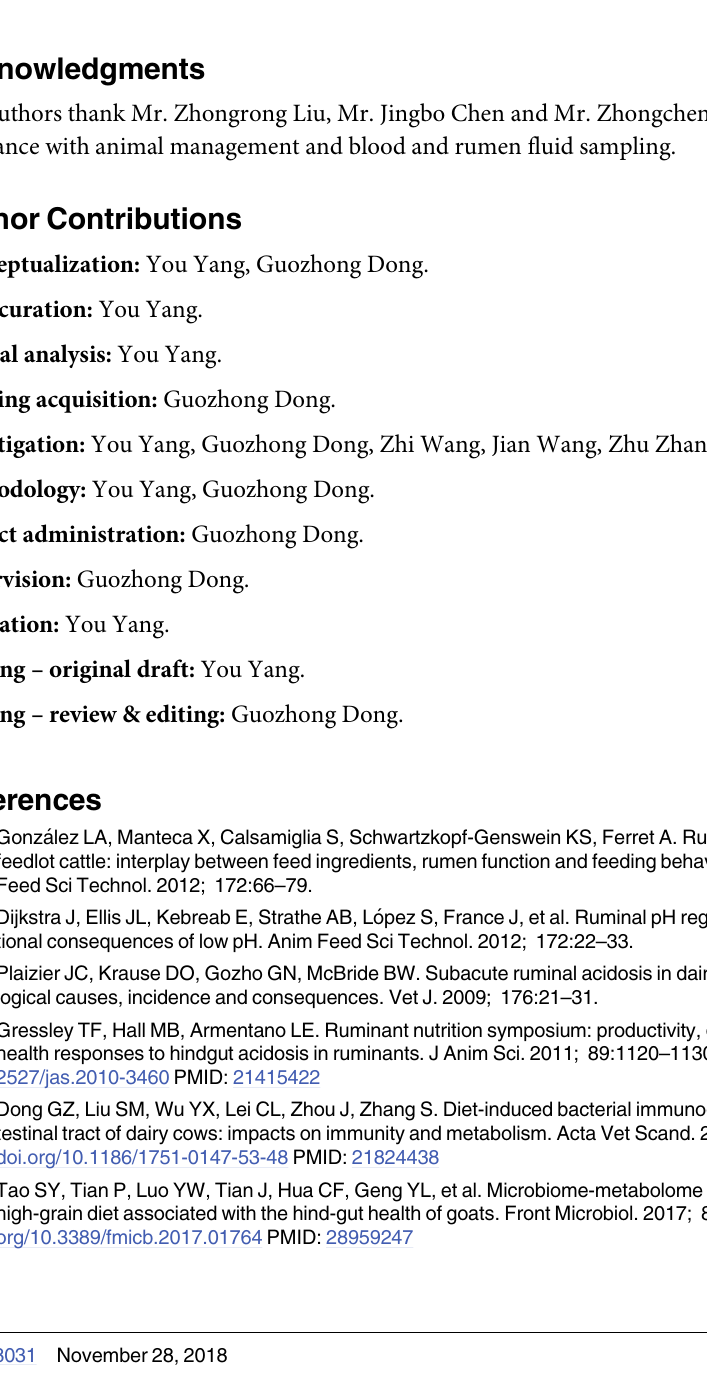
S4 Table. Metabolic pathway analysis in plasma. S1 Fig. Score scatter plot of PCA model for baseline metabolomics analyses of 24 beef steers for selecting the experimental animals. S2 Fig. TIC diagram of QC samples. S3 Fig. Score scatter plot of the PCA